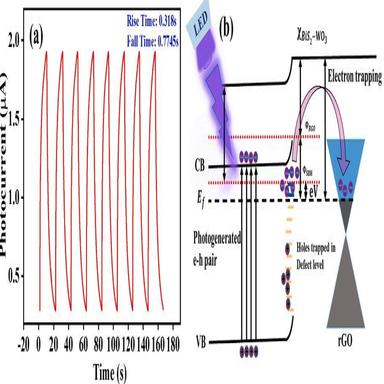
Time-dependent photoresponse of the fabricated device with rise and fall time (a), and schematic energy-band diagram for photogenerated electron transportation (b).